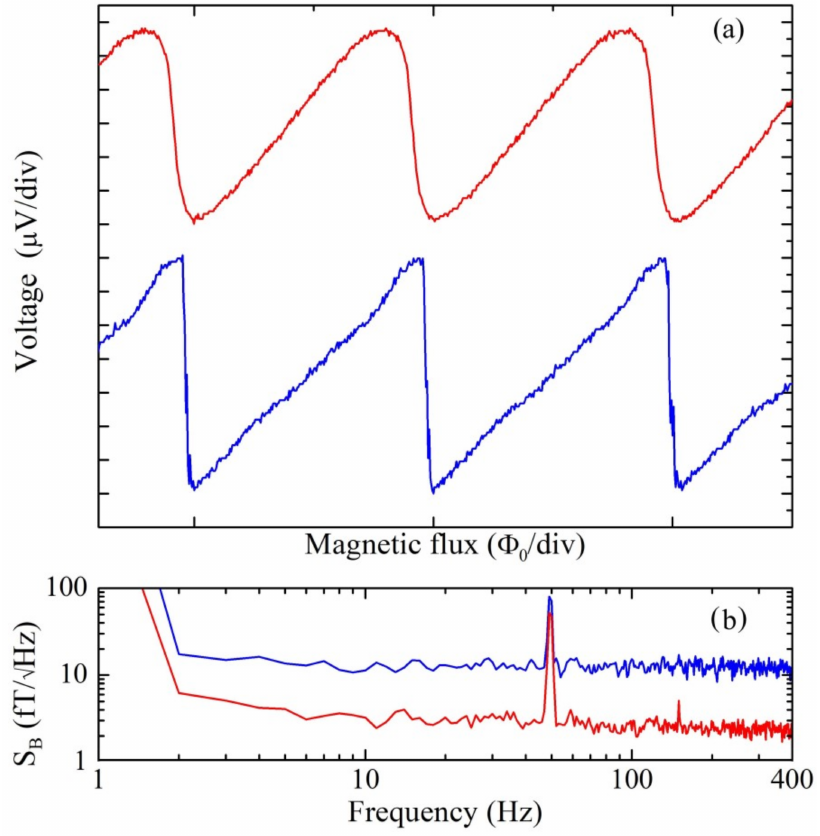
Figure 5. ( a ) Voltage–magnetic flux characteristics of a SQUID magnetometer having a non-optimal critical current value (blue curve) and after sending a current of 6.5 mA into the integrated heater (red curve). ( b ) Spectral density of magnetic field noise of the same sensor before (blue trace) and during the local heating (red trace). These measurements were performed at liquid helium